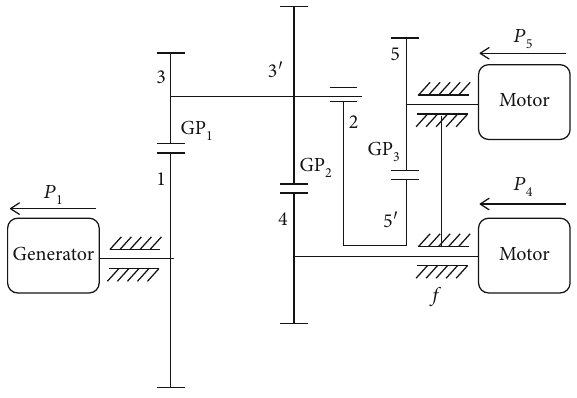
Figure 1: A PGT having 2 inputs and 1